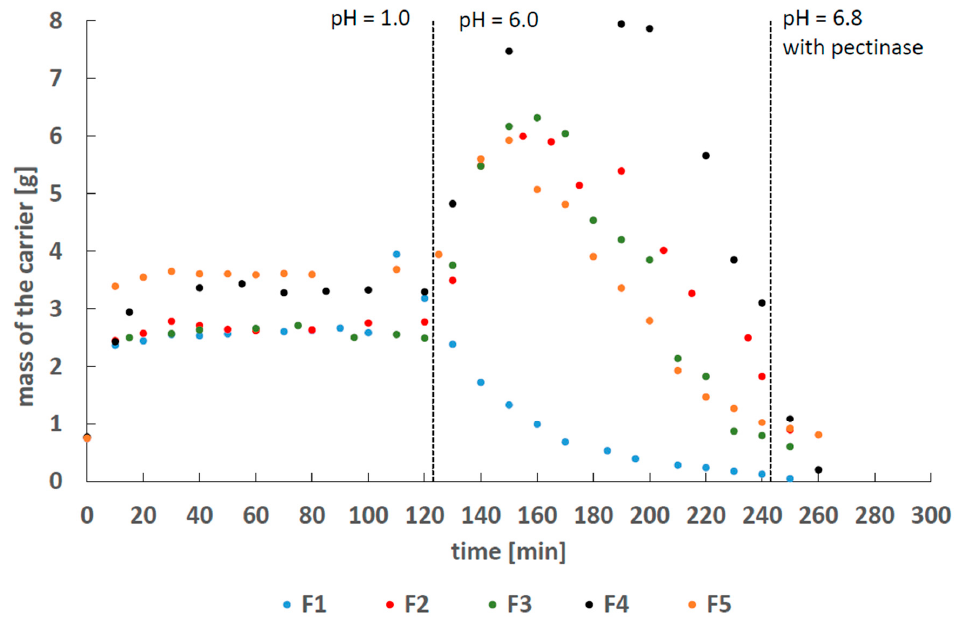
Figure 3. The mass variability of the carrier in time, in the solution of pH = 1, pH = 6.0 and pH = 7.4 with pectinase.